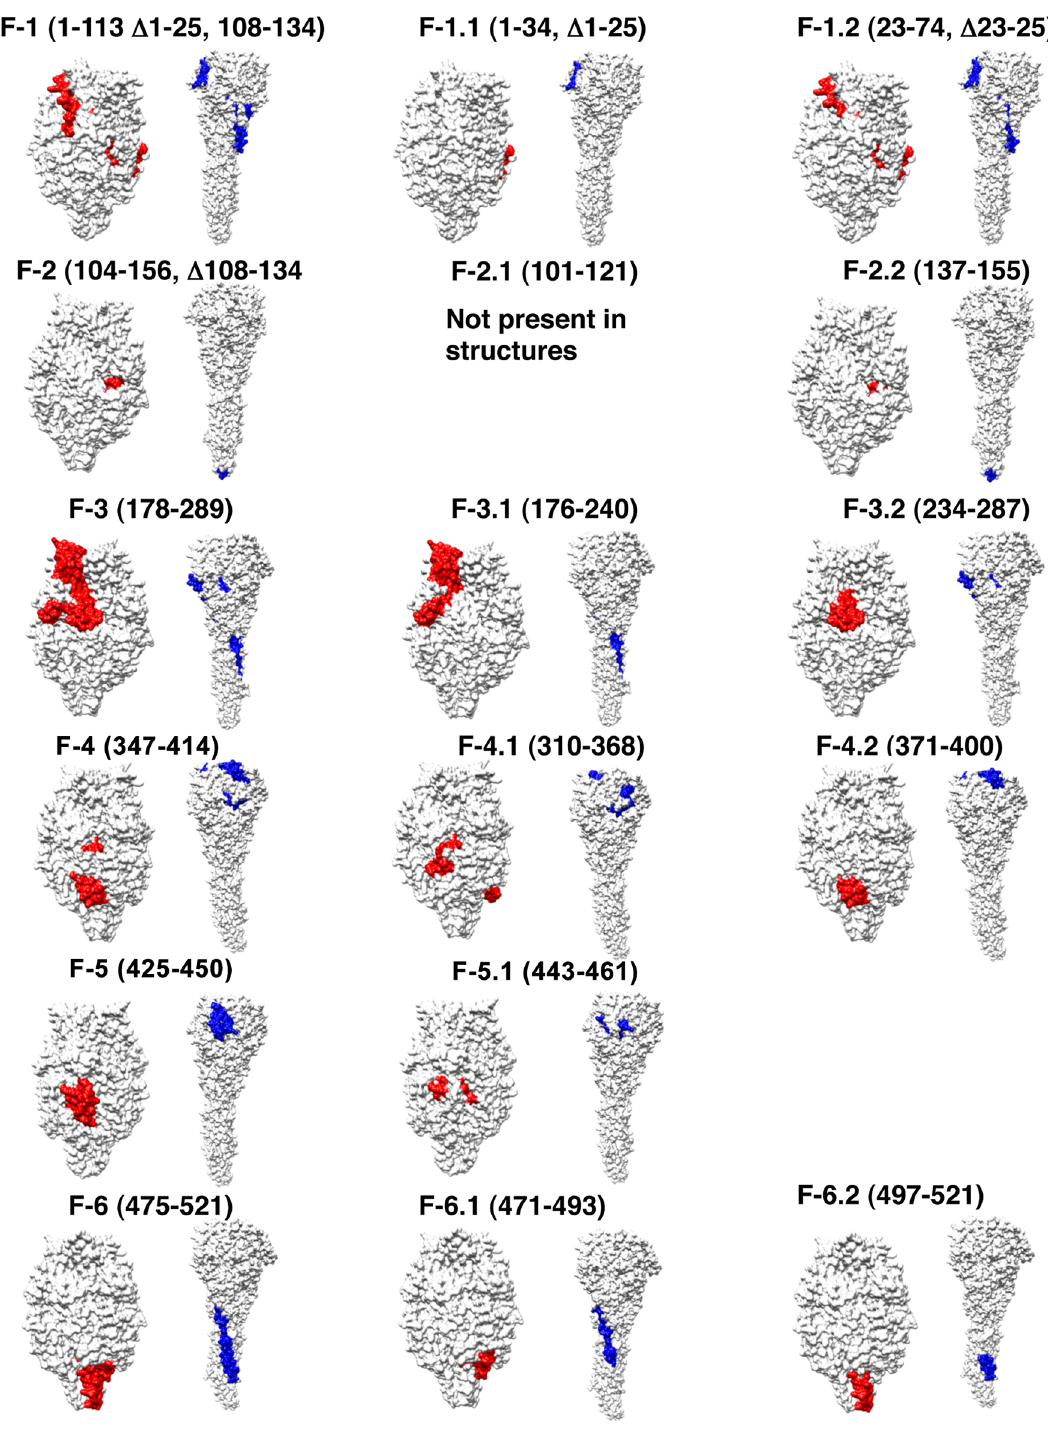
Fig 3. Structural representation of antigenic sites in pre- and post-fusion form of F identified using GFPDL. The surface structure of the pre-fusion trimeric form of RSV F protein (PDB Id — 4ZYP) is shown in white and the antigenic region in a monomer (chain A) is highlighted in red. The surface structure of the RSV F post-fusion trimer (PDB Id — 3RRT) is shown in white and the antigenic regions from one monomer are highlighted in blue. The RSV F protein used for crystallography encompasses amino acid residues 26-513del108-134 of the complete 574 a.a. long protein sequence. In addition, amino acids 98 – 109 are not represented in the